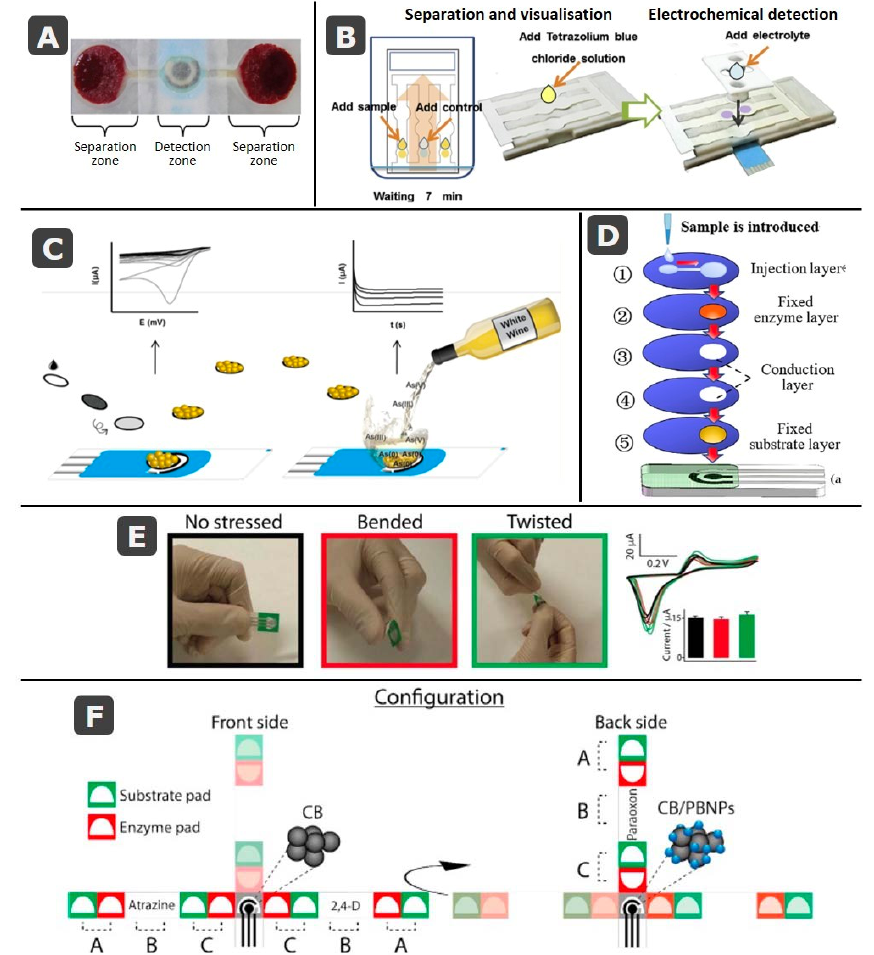
Figure 6. SPE cards combined with paper elements: ( A ) Picture of the paper-based device developed by Noiphung et al. for whole blood separation and glucose determination. Reprinted from [79], Copyright (2013), with permission from Elsevier. ( B ) Schematic representation of the separation, visualization and measurement steps in the paper-based devices developed by Primpray et al. for the determination of steroids. Reprinted from [92], Copyright (2019), with permission from Elsevier. ( C ) Schematic representation of the paper-based system for in-situ generation of gold nanoparticles and further analysis of arsenic developed by Nuñez-Bajo et al. Reprinted with permission from [105]. Copyright (2017) American Chemical Society. ( D ) Schematic diagram of the multilayer platform developed by Yang et al. for pesticide detection. Reprinted with permission from [95], Copyright (2020) Wiley Periodicals LLC. Fully-integrated paper-based electrochemical devices: ( E ) Evaluation of the robustness of the paper-based device developed by Cinti et al. for the detection of chloride ions, after 100 repeated bending (red) and twisting (green) tests. Reprinted from [114], Copyright (2017), with permission from Elsevier. ( F ) Schematic diagrams of the configuration of the origami device developed by Arduini et al. for the detection of pesticides. Reprinted from [115], copyright (2018), with permission from